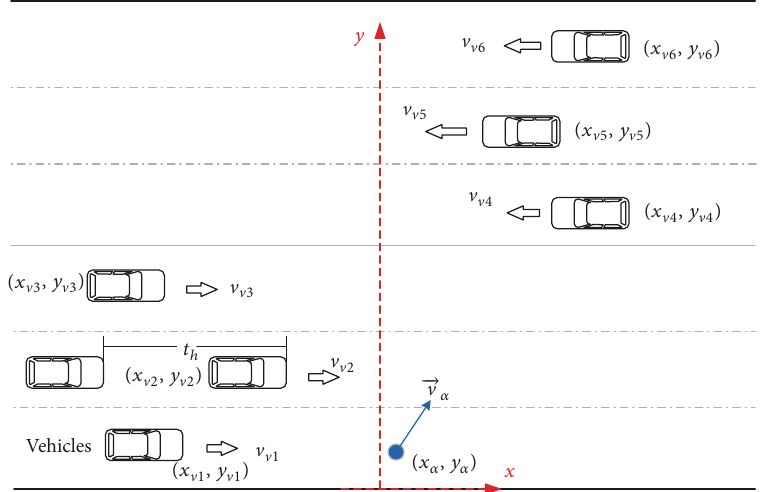
Figure 4: Schematic diagram of pedestrian crossing ( 𝑁 = 6 ).